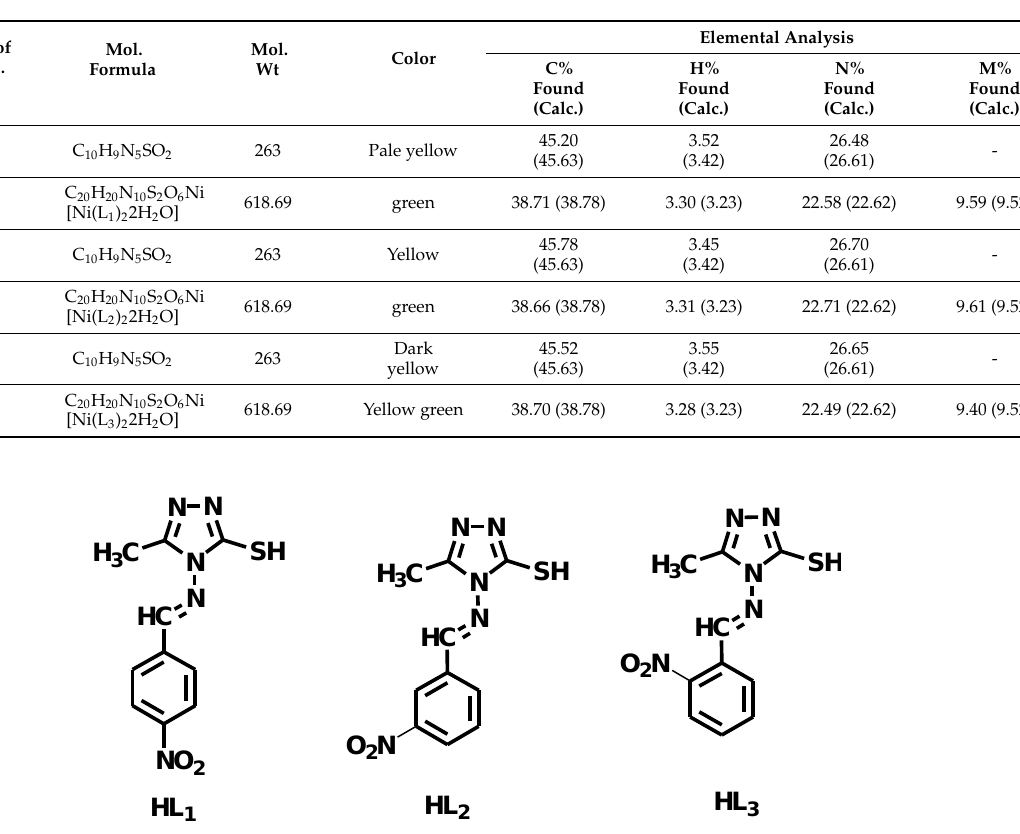
Table 1. Physical and analytical data of ligands and metal complexes.